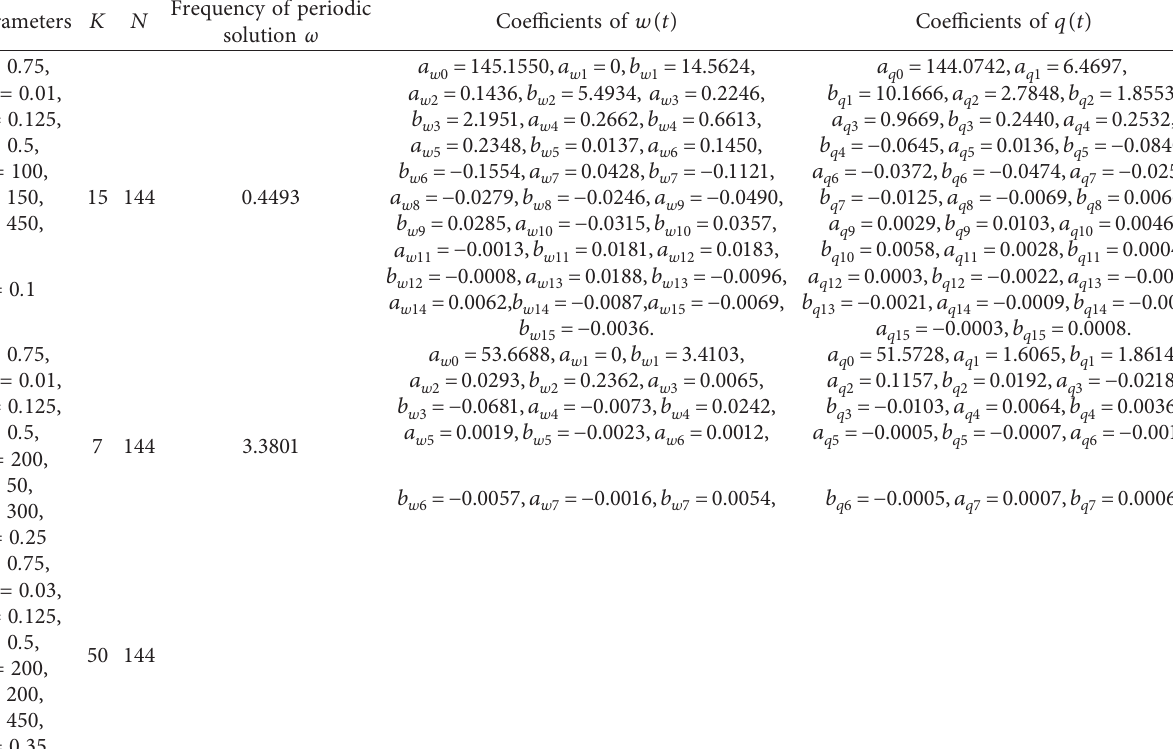
Figure 4: The phase portraits are displayed in (a) where solid blue lines are numerical results, ∗ results of the HB-AFT method, and k � 0 . 75 ,C � 100 , α � 0 . 125 , β � 0 . 5 ,b � 50 , p � 0 . 1 , and b � 450. l � 0 . 5, respectively. The comparisons of amplitudes of w in the numerical simulations and the first-order harmonic amplitudes 0 . 49 , and T 1 of w by HB-AFT are presented in (b) where the solid blue line is the amplitude of numerical simulations and red ° are the first-order harmonic amplitudes. Table 2: Results of the closed approximate periodic solutions in system